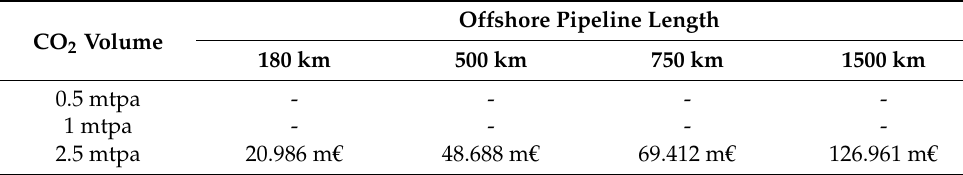
Table 16. The offshore pipeline